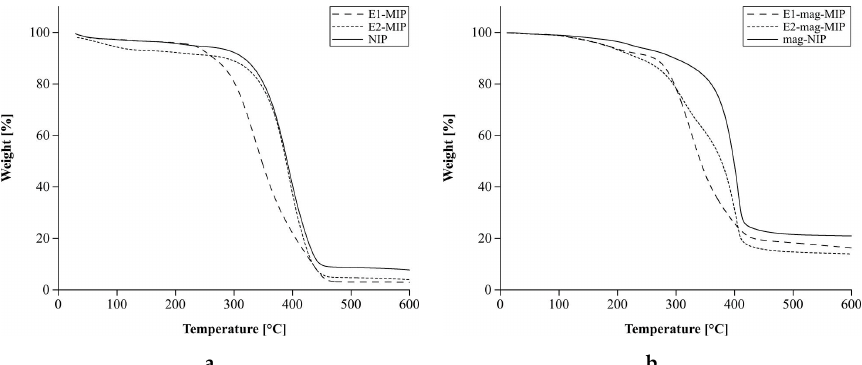
Figure 4. Thermogravimetric curves of: ( a ) E1-MIP, E2-MIP, and NIP; ( b ) E1-mag-MIP, E2-mag-MIP, and mag-NIP.